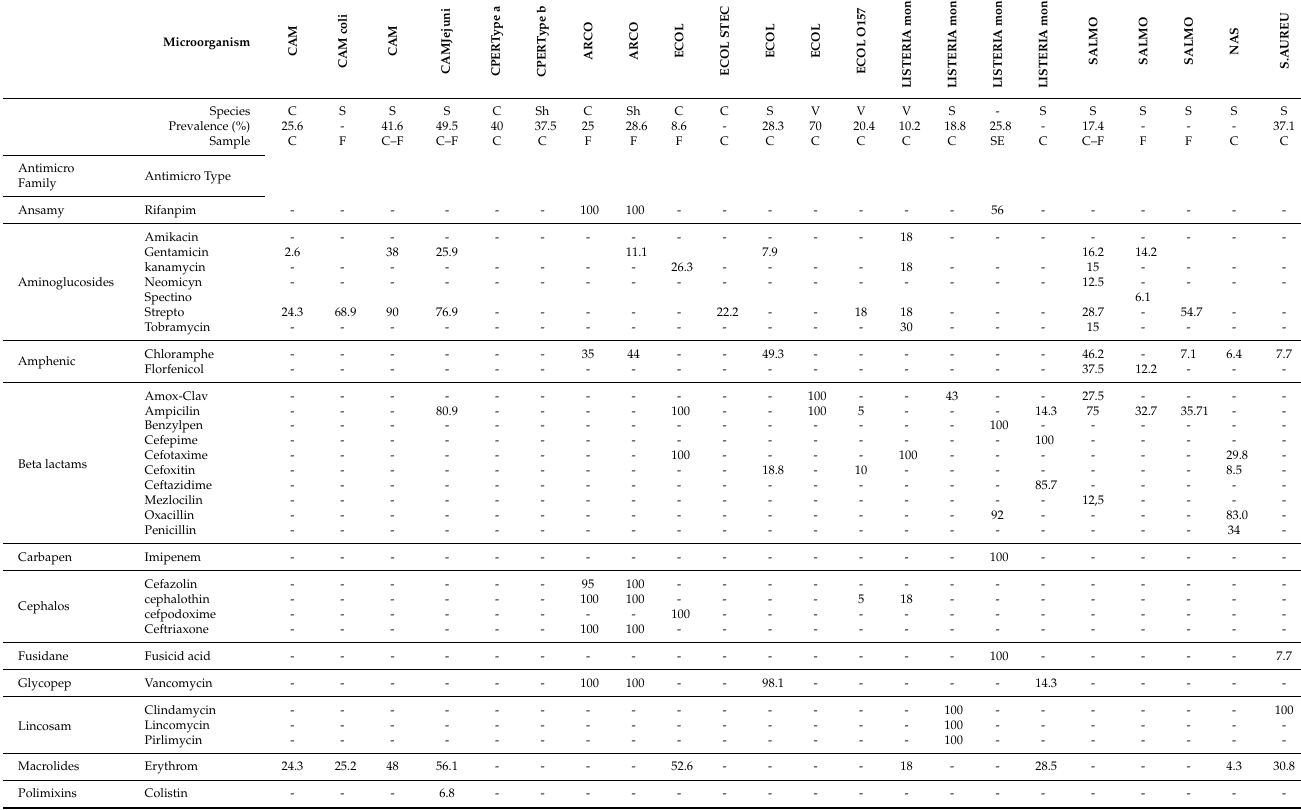
Table 8. Antimicrobial resistance of several foodborne and zoonotic agents isolated from slaughterhouses.